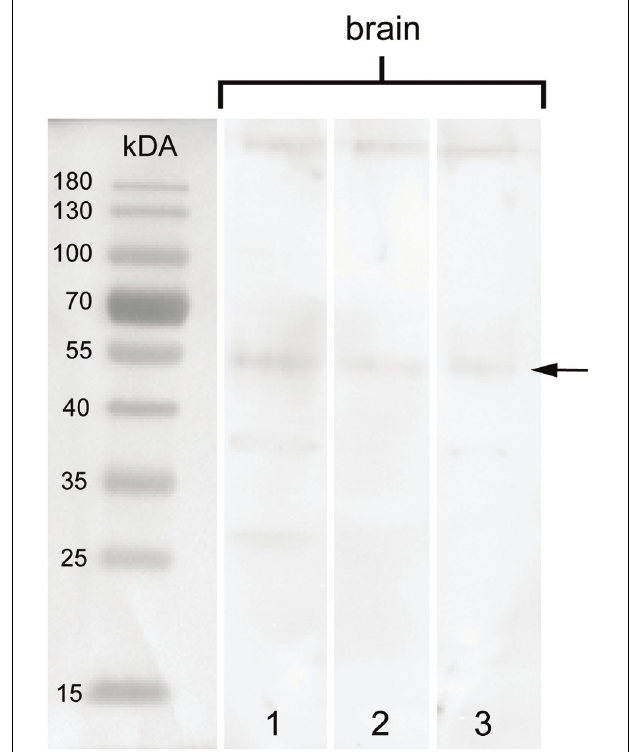
FIGURE 6 | Western blot of arthropsin antisera using brain tissue of Euperipatoides rowelli . Different lanes contain different dilutions of protein extract. Lane 1: Supernatant of extracted proteins (35.84 µ g). Lane 2: Supernatant of extracted proteins at lower concentration (17.92 µ g). Lane 3: Resuspended pellet in protein extraction buffer (46.787 µ g). Note a distinct band at 55 kDA in all lanes